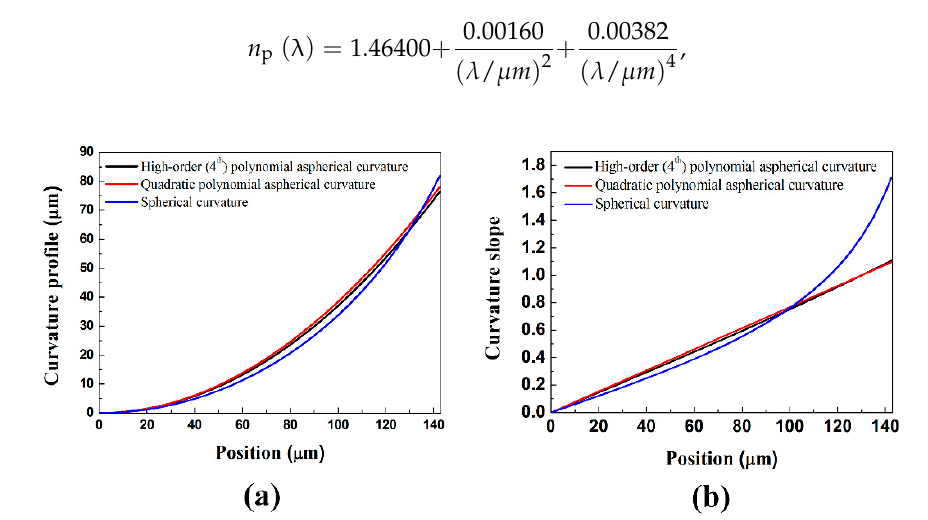
Figure 6. ( a ) Positional curvature profiles and ( b ) positional curvature slopes for the high- ∆ n LC GRIN lens arrays with spherical, quadratic polynomial aspherical, and high-order (fourth-order) polynomial aspherical curvatures.